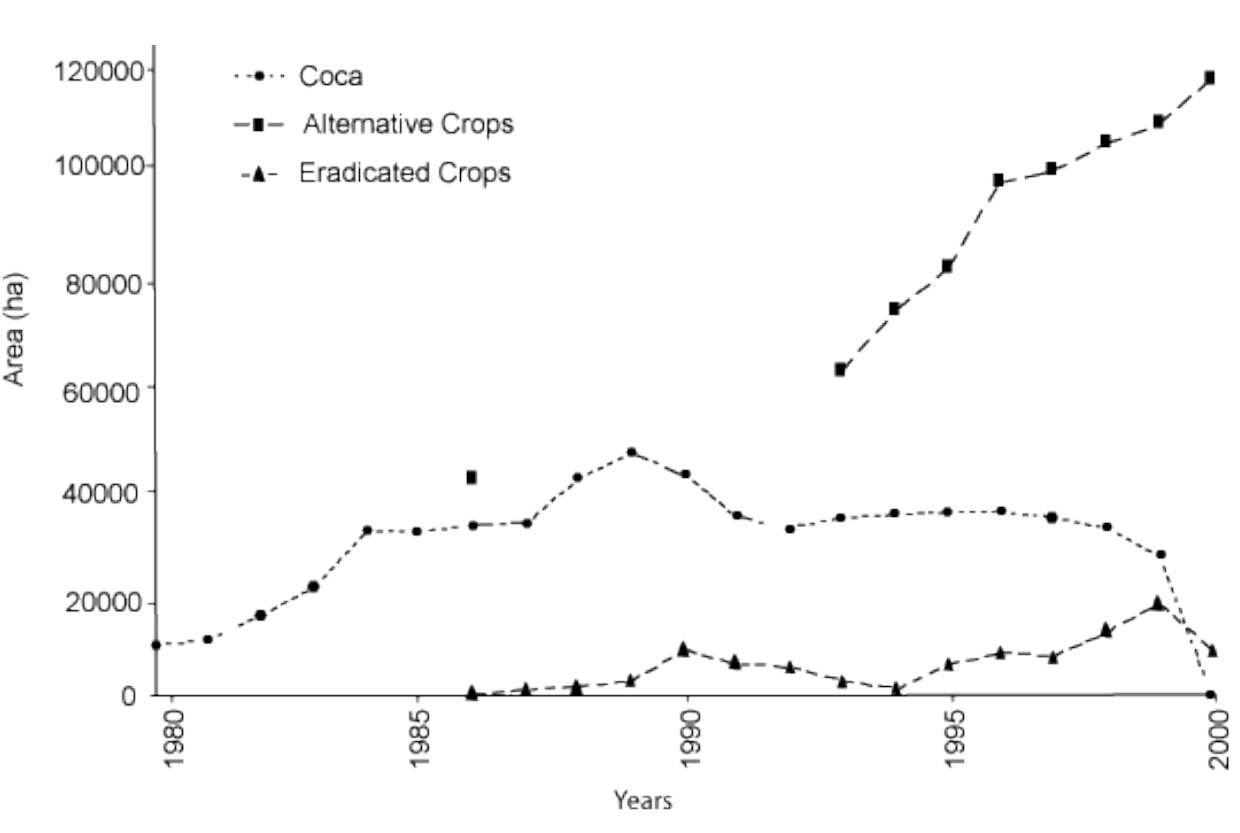
Fig. 6. Areas of coca grown, coca eradicated, and substitute crops grown in Chapare, 1980–2000. The zero value for the amount of coca grown in 2000 is most likely related to propaganda at the time, rather than an actual value. (Sources: area of coca and substitute crops, Millington et al. 2003; eradication